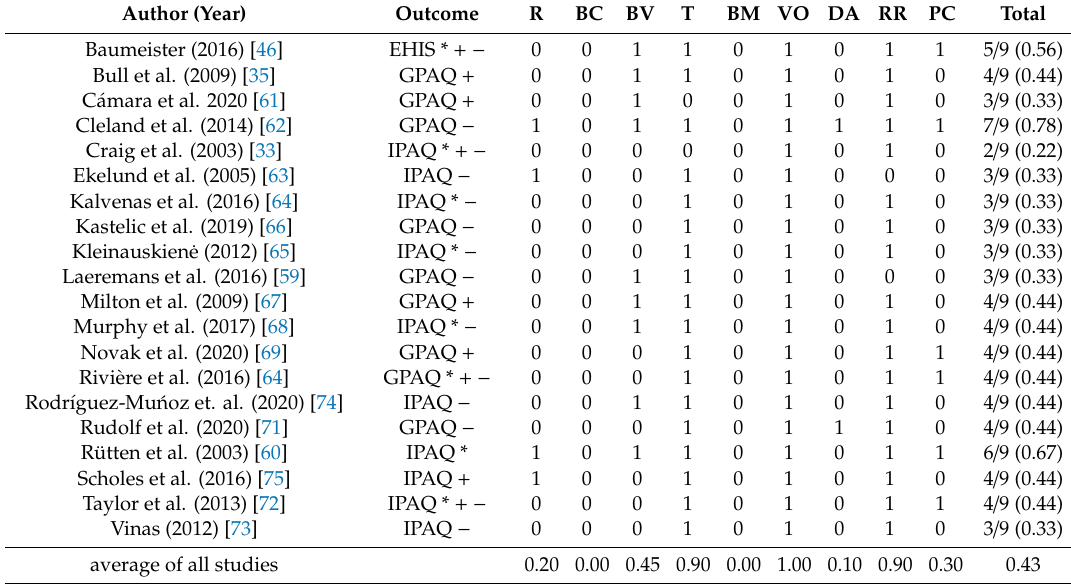
Table 4. Results of the risk-of-bias